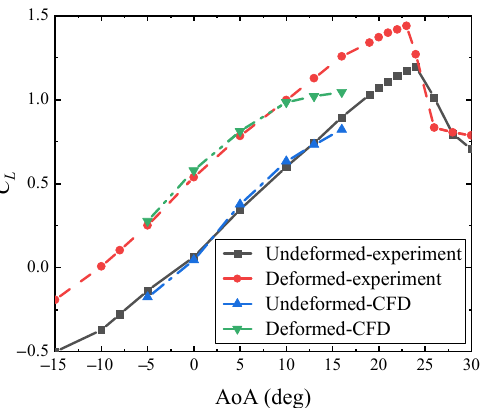
Figure 24. Comparison of lift curve between numerical and experimental results.